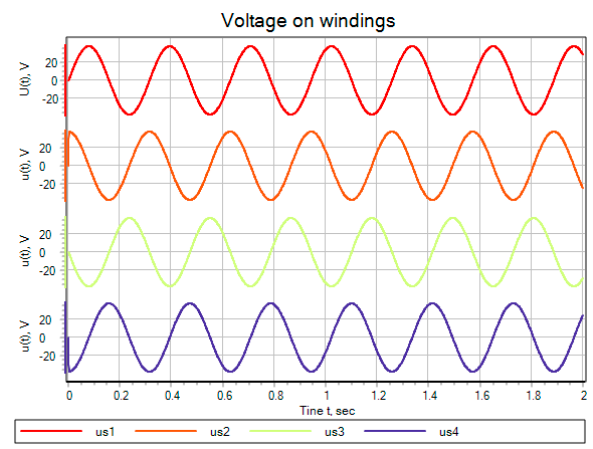
Figure 15. Voltage across the stator windings.